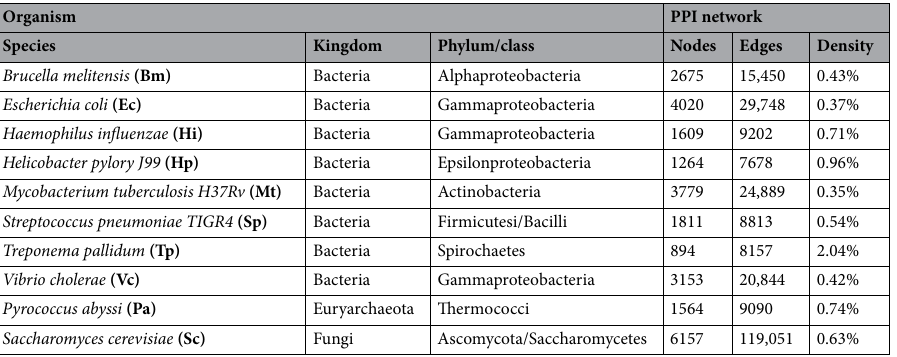
Table 1. Complete list of considered organisms, together with their network size (nodes and edges). Density is expressed as the ratio between the actual number of edges and the number of edges in the complete graph with the same number of